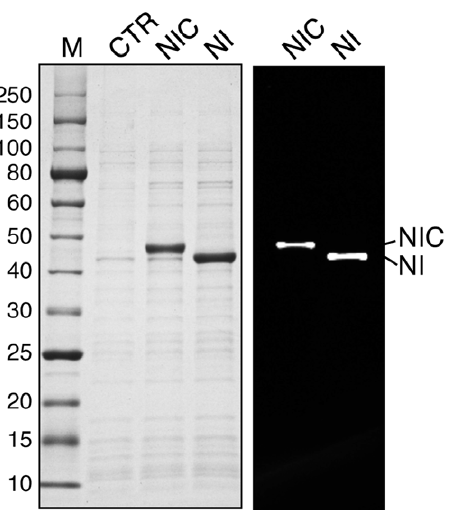
Figure 4. The native Arsp-FB24 Arth_1007 precursor in inactive. The native Arsp-FB24 Arth_1007 precursor (NIC) was expressed in E.coli with the addition of an N-terminal His tag. Because the C-extein is only 14 residues, a precursor truncated at the intein C- terminus (NI) was also expressed. The left panel is a SDS-PAGE of soluble lysates after in vivo expression at 37 u C stained with Simply Blue Safe Stain and the right panel is a Western blot of the same samples run in the same gel. Proteins containing the N-terminal His tag were detected with the anti-His tag antibody. The control lane (CTR) contains soluble lysates from E.coli with just an empty plasmid. The sizes of the molecular weight standards (M) are listed in kDa (New England Biolabs 10 to 250 kDa ladder).